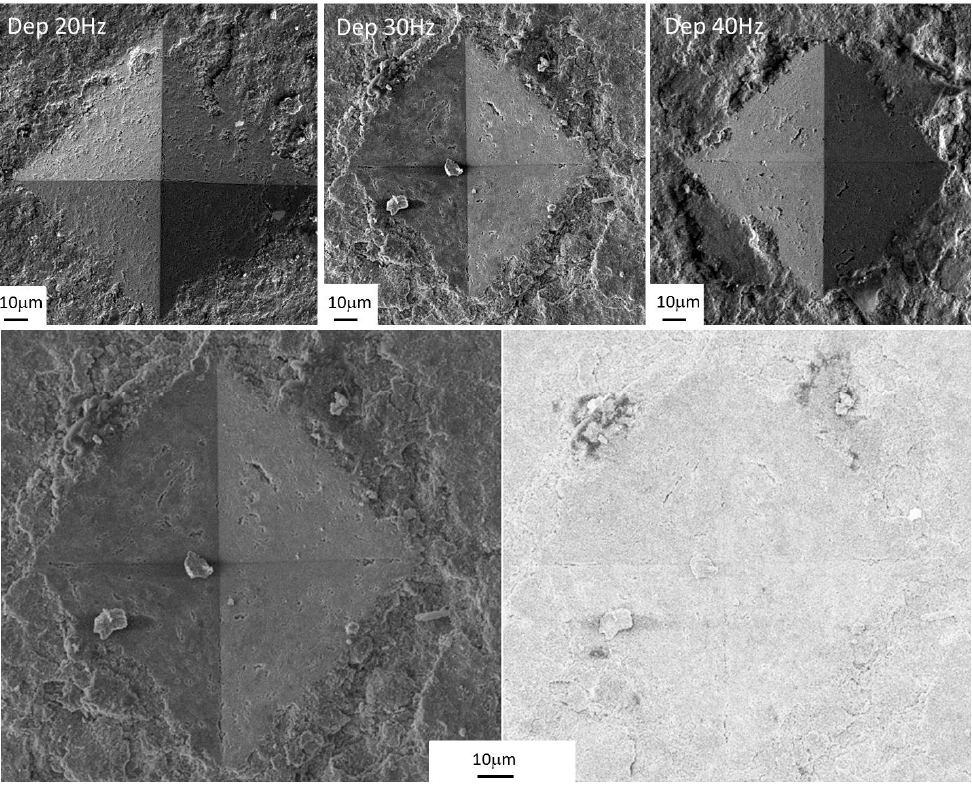
Figure 12. SEM images of the indenter imprint.